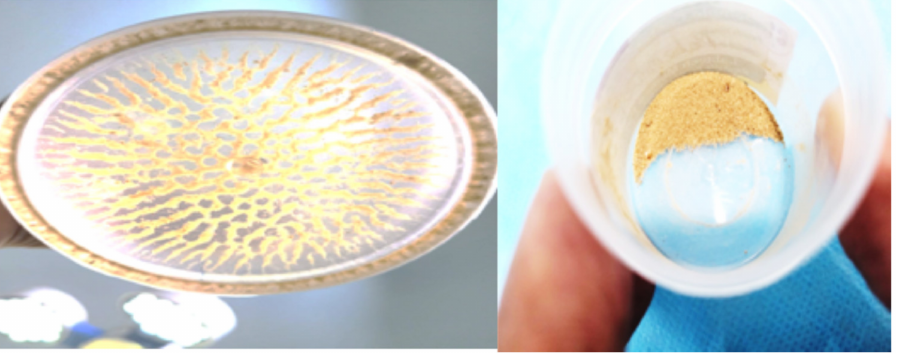
Figure 2. Dust aspirated through the DISS